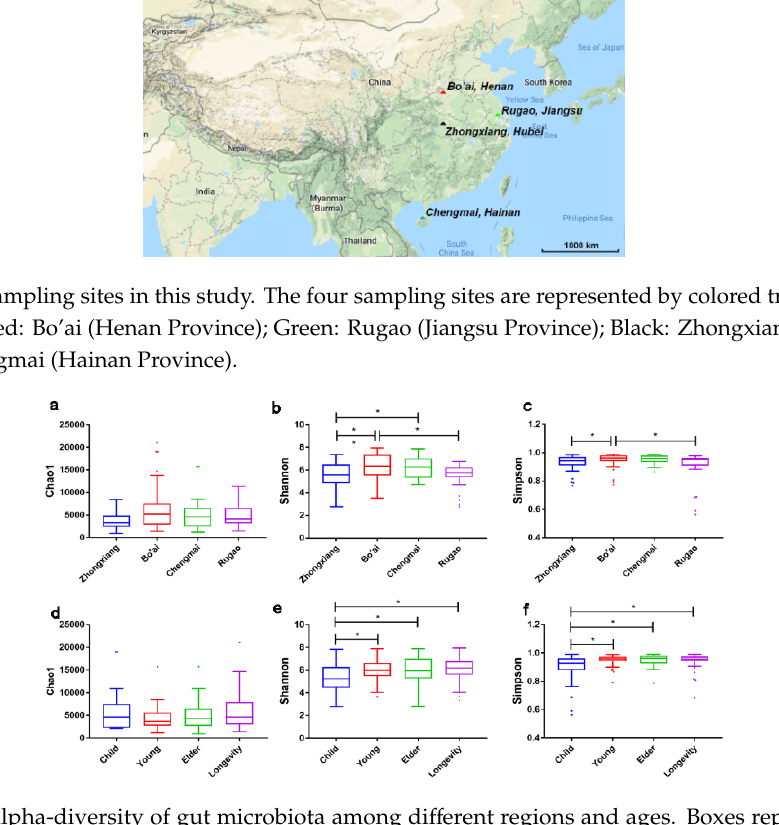
Figure 2. Alpha ‐ diversity of gut microbiota among different regions and ages. Boxes represent the interquartile range (IQR) between the first and third quartiles, and the lines inside the boxes represent the median. Whiskers denote the lowest and highest values within 1.5 × IQR from the first and third quartiles, respectively. The colored points represent the values with distance from the median exceeding 1.5 × IQR. ( a – c ) Chao1, Shannon and Simpson indexes of each region. ( d – f ) Chao1, Shannon and Simpson indexes of each age. * indicates that the difference is significant, p < 0.05.